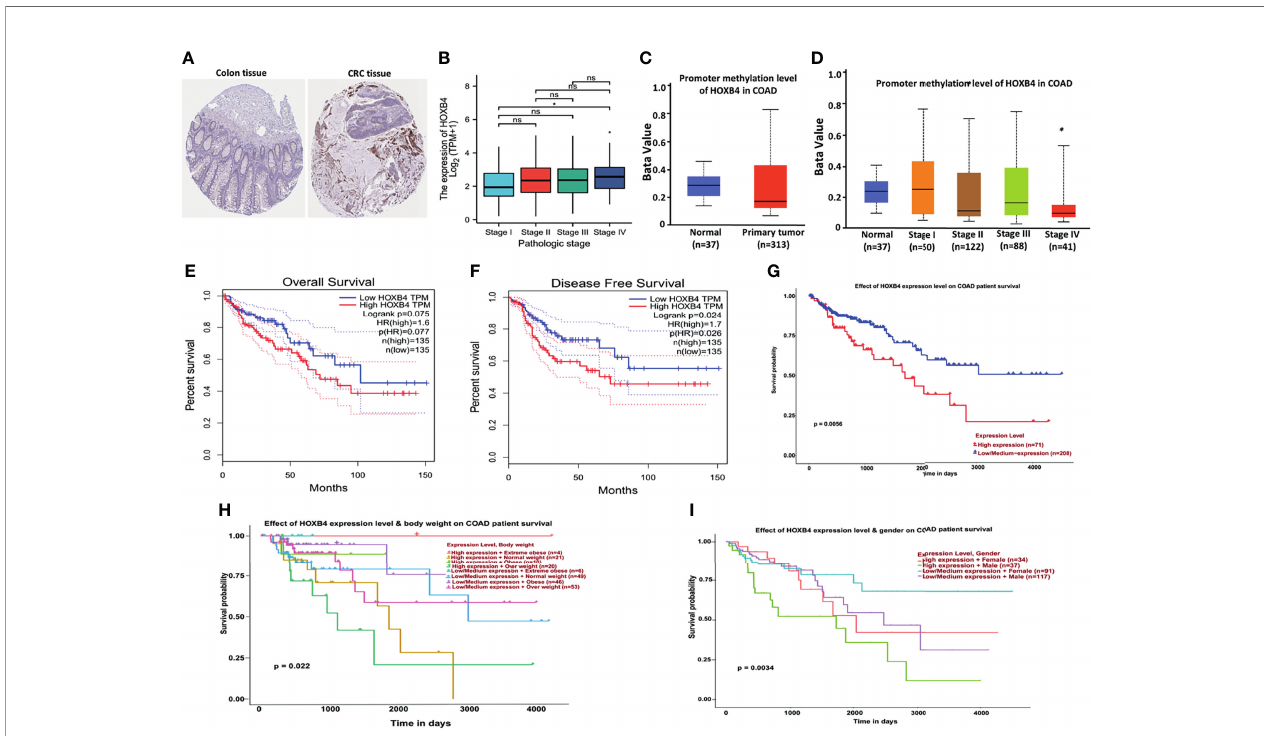
FIGURE 3 | Correlation between HOXB4 and prognosis of colorectal cancer. (A) Protein expression of HOXB4 in COAD tissue and in normal tissue. (B) Correlation between the HOXB4 gene expression levels and the main pathological stages. (C) The promoter methylation level of HOXB4 in the primary tumor tissue and the normal tissue in COAD. (D) Low promoter methylation level of HOXB4 in pathological stage IV of COAD. (E, F) The HOXB4 gene expression-related overall survival and disease-speci fi c survival of COAD tumor in TCGA. (G – I) Association between HOXB4 and survival of COAD patients. * P <0.05 was considered statistically signi fi cant. COAD, colon adenocarcinoma; ns, no signi fi